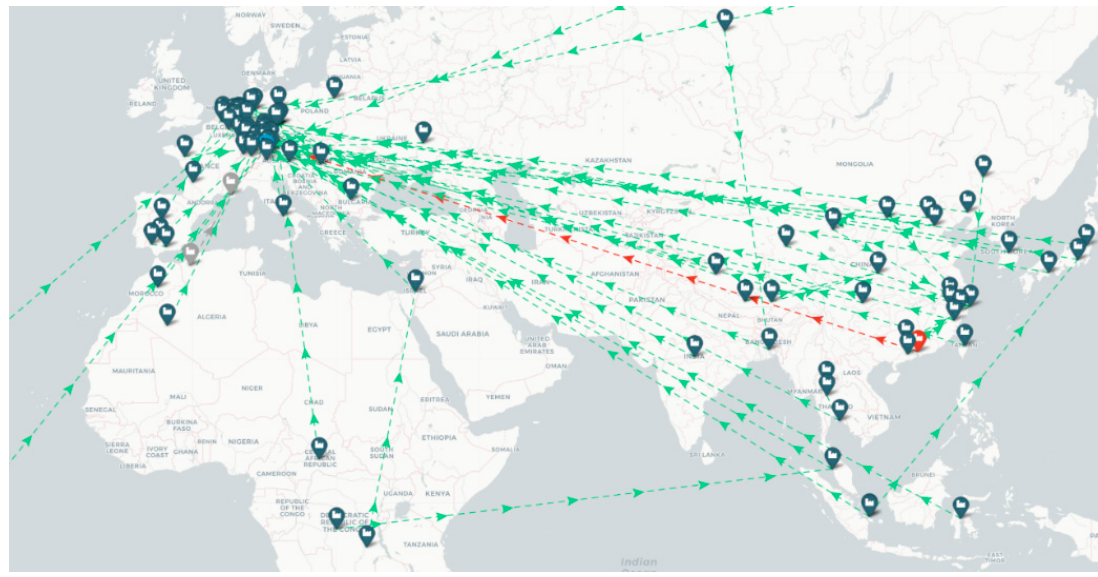
Figure 16. Supply network visualization.